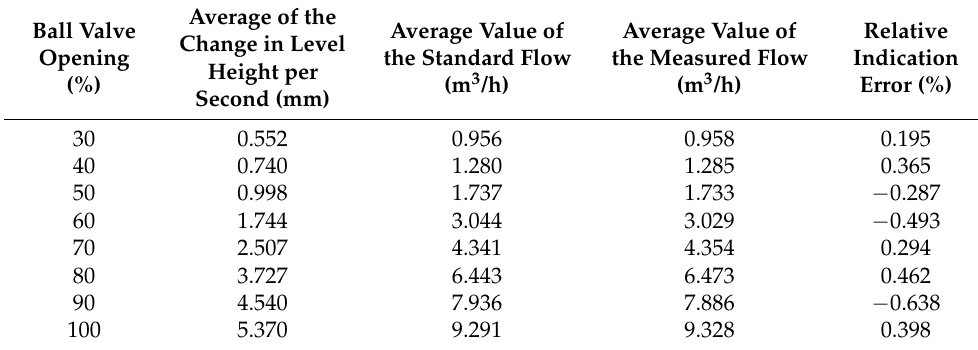
Table 6. Measurement results under DN55 pipe